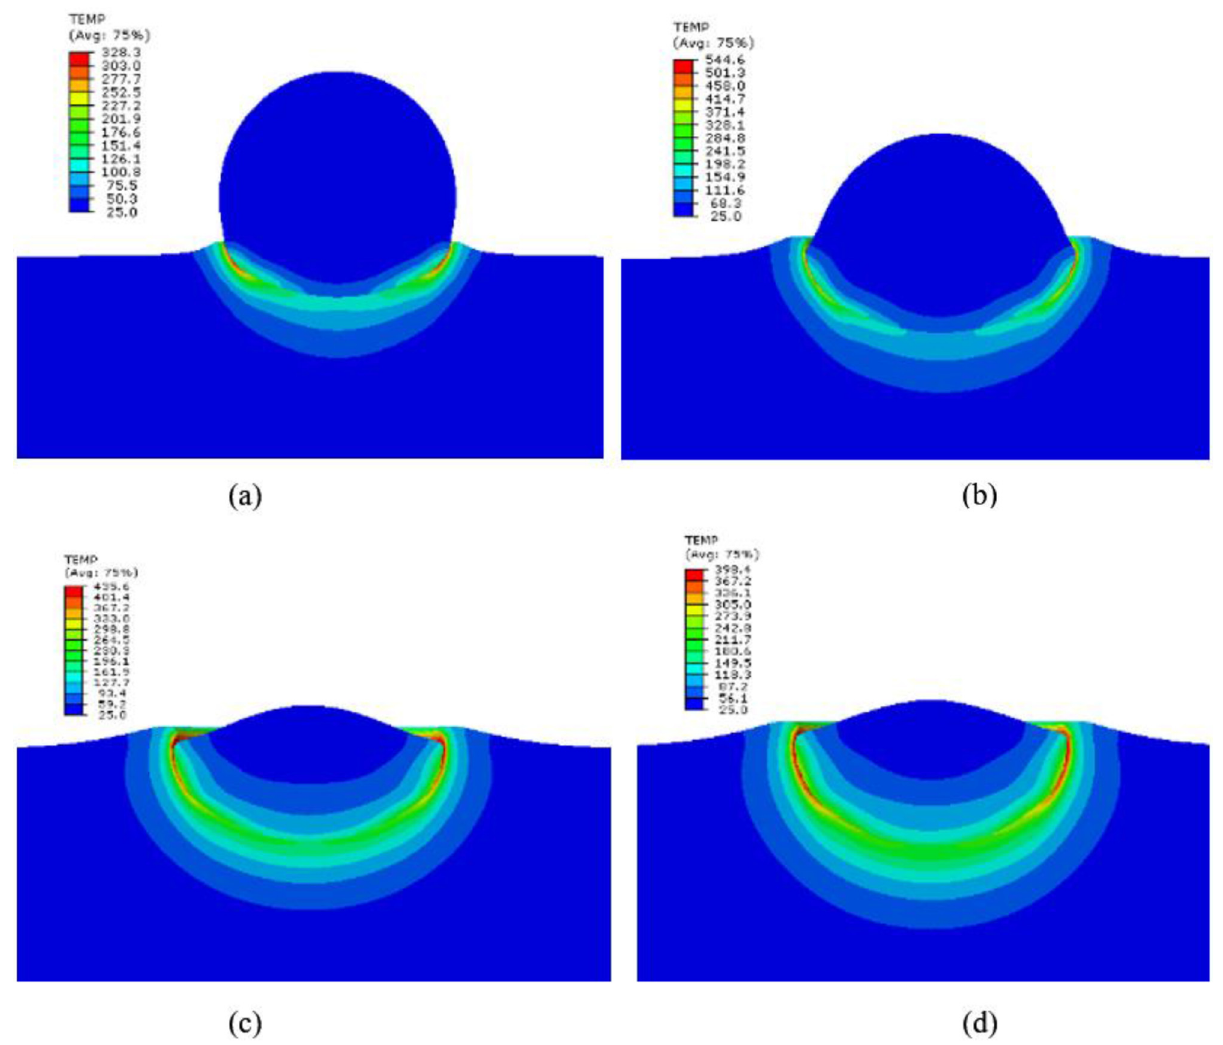
Fig. 3. The temperature evolution at 500m/s Cu/Al impact of (a) 5ns (b) 10ns (c) 20ns (d) 30ns by using the Lagrangian numerical